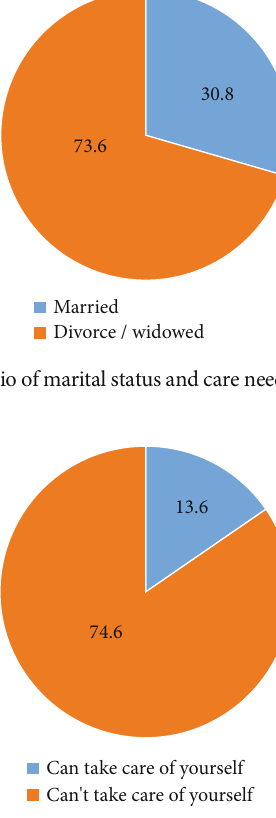
Figure 4: The proportion of whether the researchers took care of themselves and needed